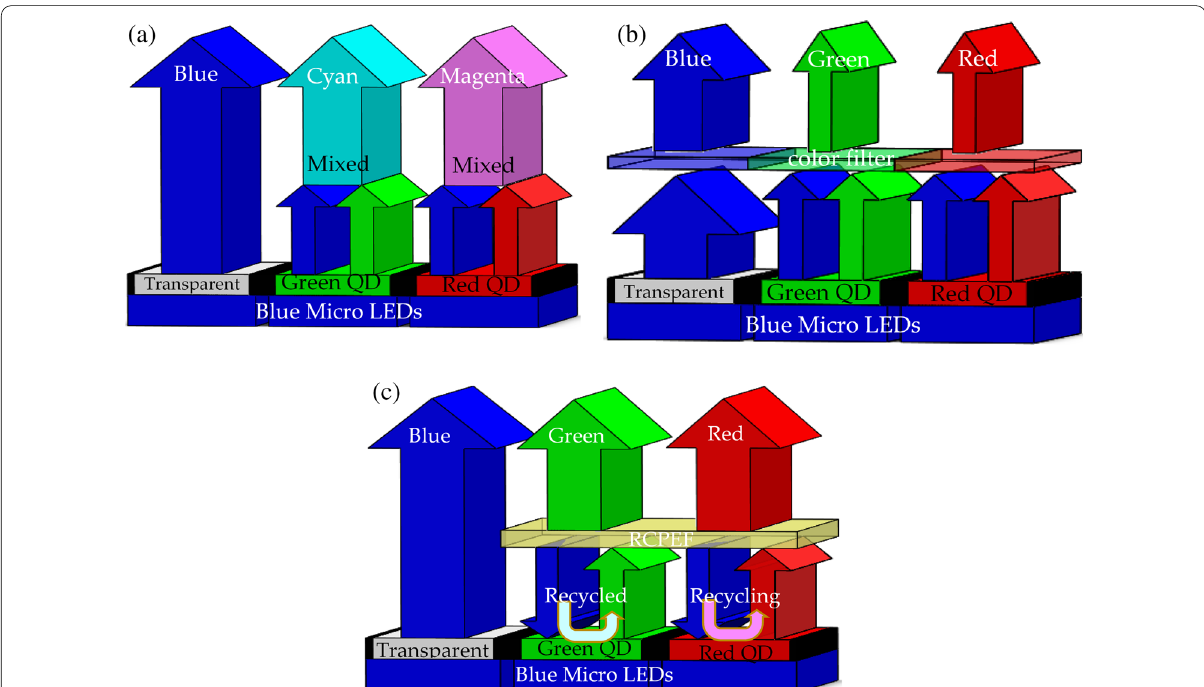
Fig. 3 RCPEF color purity improvement principle: a no RCPEF light emission, b traditional color filter architecture, and c combined RCPEF light emission